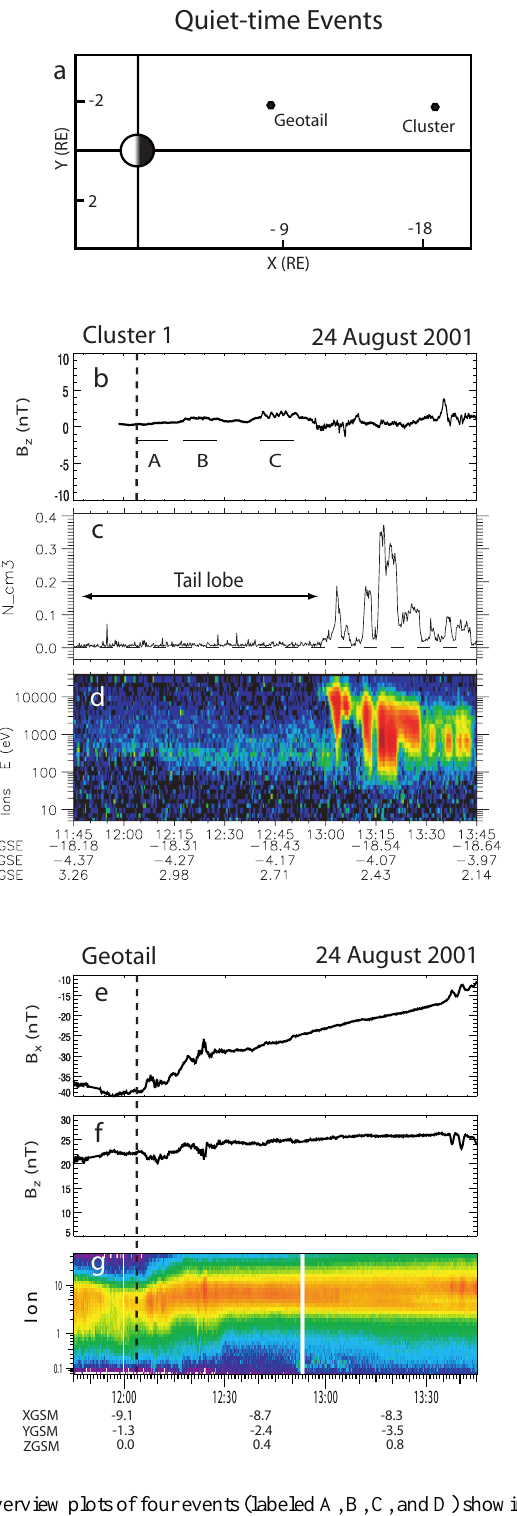
Fig. 1. Overview plots of four events (labeled A, B, C, and D) showing Cluster and Geotail data and their locations in the X-Y plane: (a–g) 24 August 2001 and (h–n) 8 September 2002. Cluster was inside the tail lobe during all events. Geotail was located in the plasma sheet during the 24 August events and near the outer edge of the plasma sheet during the 8 September